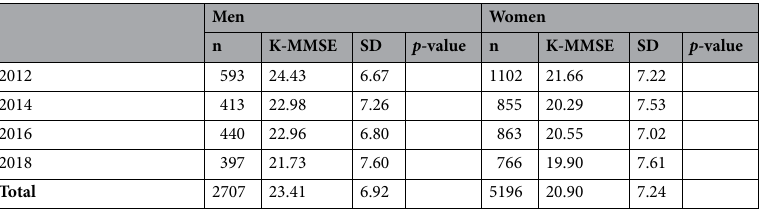
Table 1. Sociodemographic characteristics of study participants and average K-MMSE scores